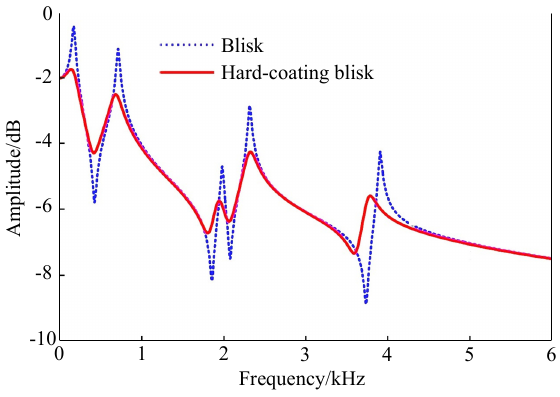
Figure 8. Frequency response functions of the blisk, with or without hard ‐ coating.